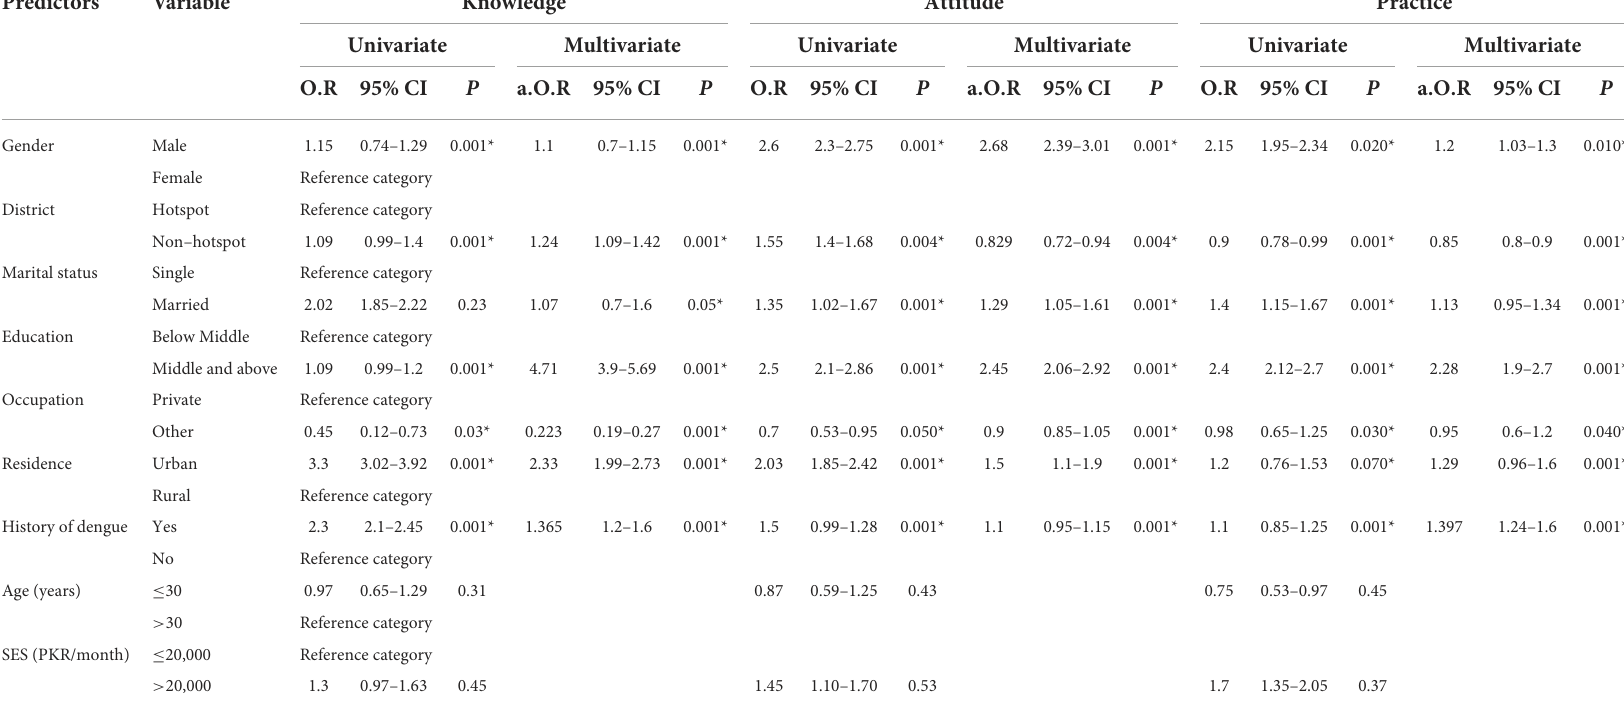
TABLE 2 Predictors of KAP levels (good vs. poor) in univariate and multivariate analysis ( n =